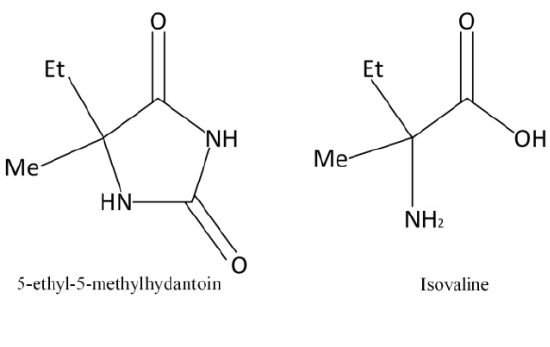
Figure 1. Structure of 5-ethyl-5-methylhydantoin and isovaline.